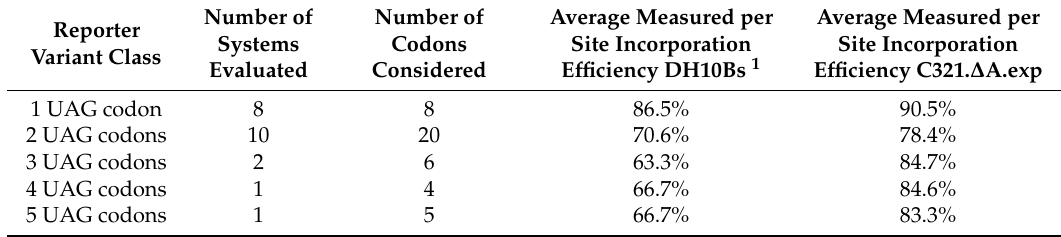
Table 3. Average measured per codon reassignment efficiency for UAG containing reporter